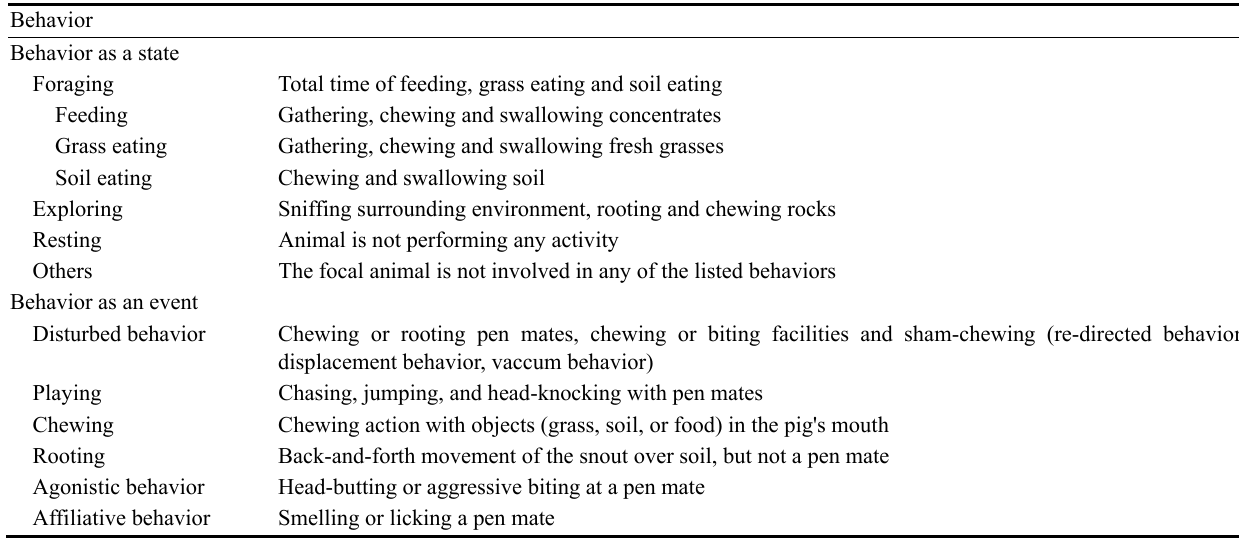
Smelling or licking a pen